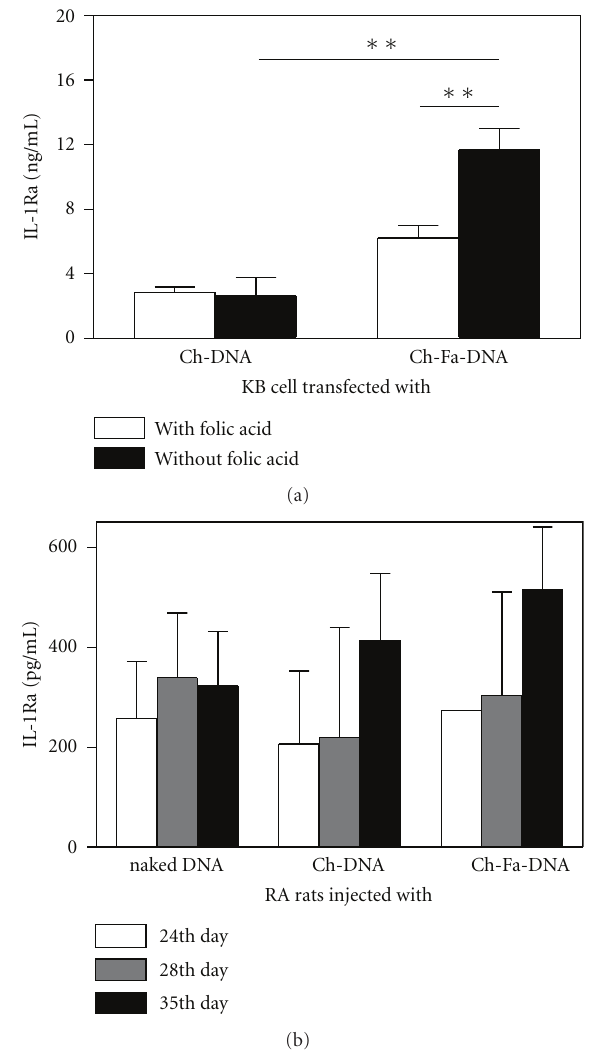
Figure 4: E ffi cient delivery of Ch-Fa-plasmid IL-1Ra DNA in vitro and in vivo . (a) In vitro , KB cells received either 5 μ g of Ch- plasmid IL-1Ra DNA nanoparticles or Ch-Fa-plasmid IL-1Ra DNA nanoparticles in the presence or absence of folic acid supplement. Values are the mean ± SEM. Statistical significance was assessed by unpaired Student t . (b) Three groups (each consisted of 3 rats) of the normal Lewis rats treated with the hydrodynamic femoral intravenous injection of 200 μ g naked β -gal plasmid, Ch- β -gal plasmid DNA, and Ch-Fa- β -gal plasmid DNA, respectively. Serum samples were collected at day 24, 28 and 35, respectively. The levels of IL-1Ra protein in the cellular cultured media and serum were analyzed by ELISA. Values were shown as mean ± SEM of three rats. All values were subjected to t test and one-way ANOVA analysis. A value of 0.05 was considered